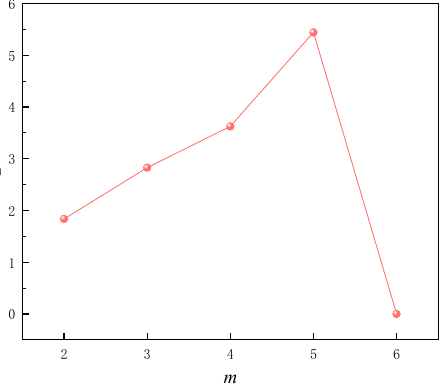
Figure 8. The relationship between phase space dimension m and correlation dimension D .